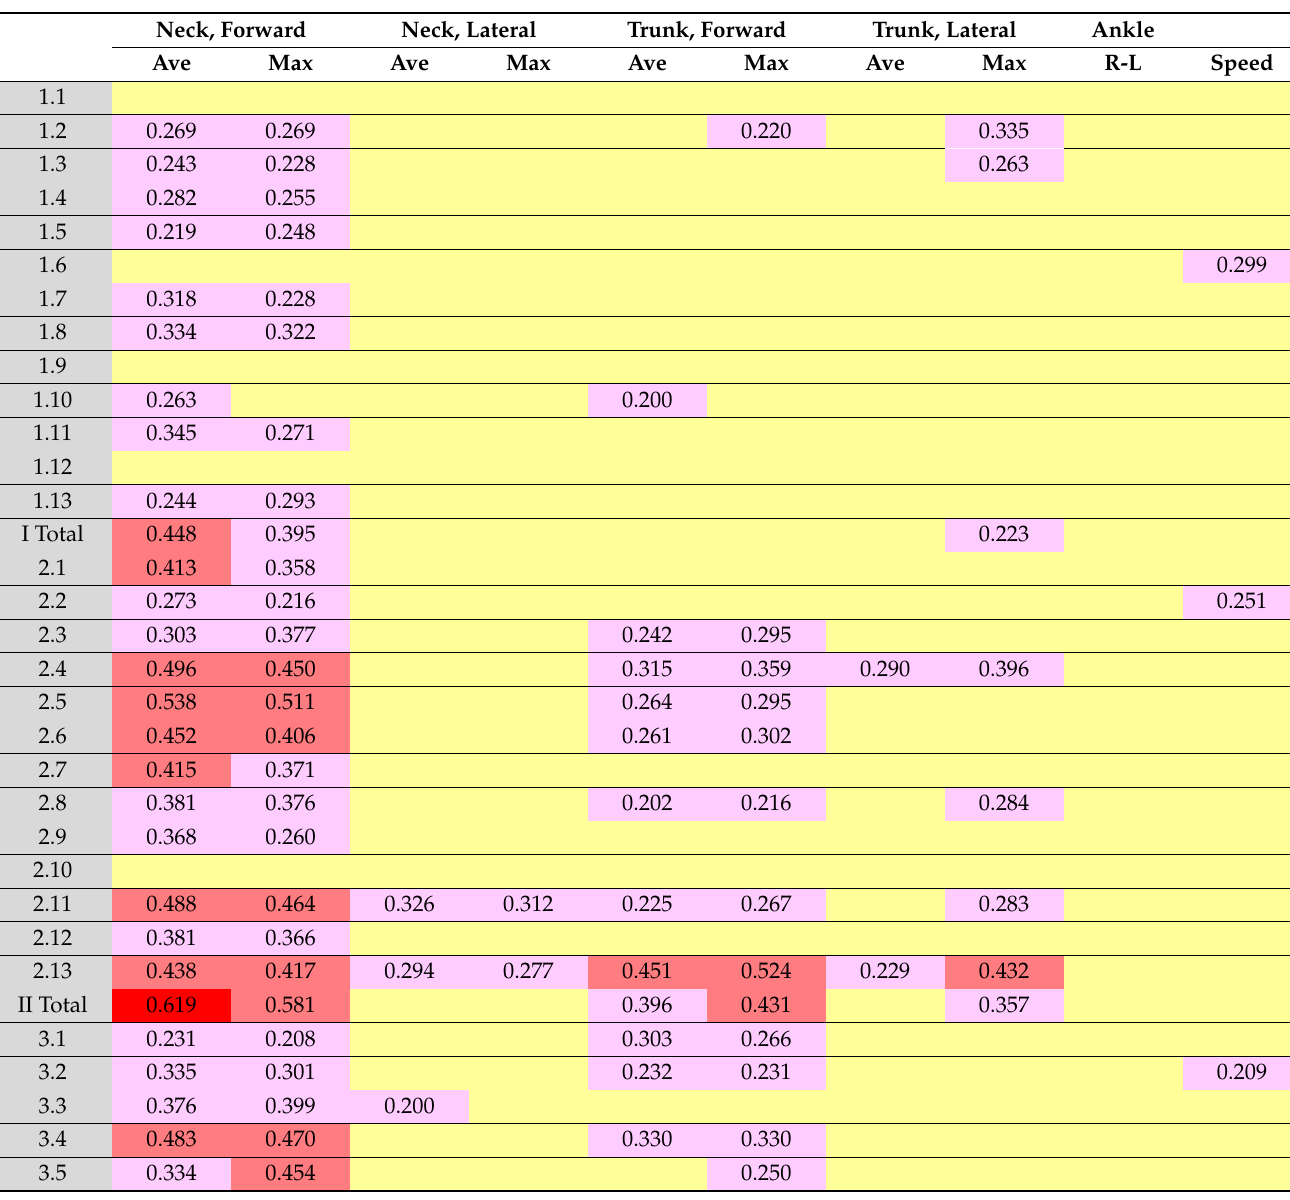
Table 3. Relationships between the neck/trunk tilt angles measured by AKIRA ® during walking and the MDS-UPDRS and the Hoehn and Yahr